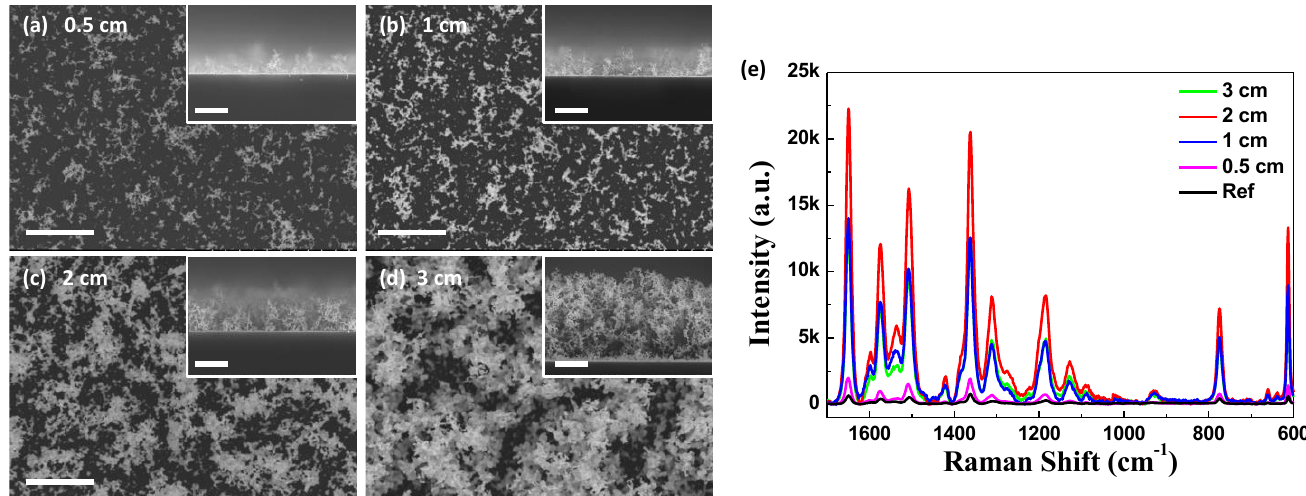
Figure 4. ( a – d ) Correlation between the thickness and the surface coverage of the nanoporous Au grown at 1 Torr. Thickness and surface coverage are controlled by different source amounts. All the scale bars are 500 nm; ( e ) SERS spectra from the nanoporous Au in ( a – d ). “Ref” indicates a spectrum from a dense thin film of Au.